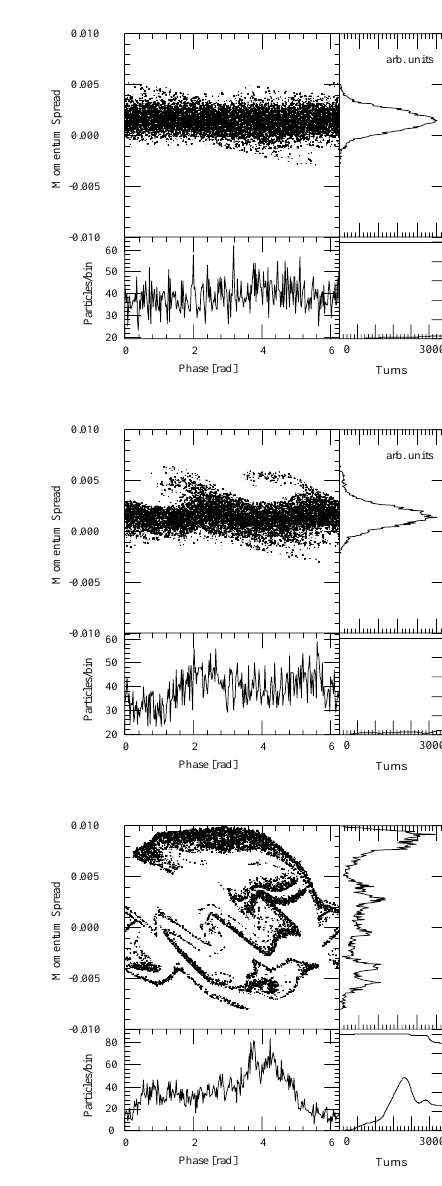
FIG. 8. The pictures corresponding to those in Fig. 7 where the feedback delay was reduced by a tenth of a revolution ( (cid:6) 35 ±